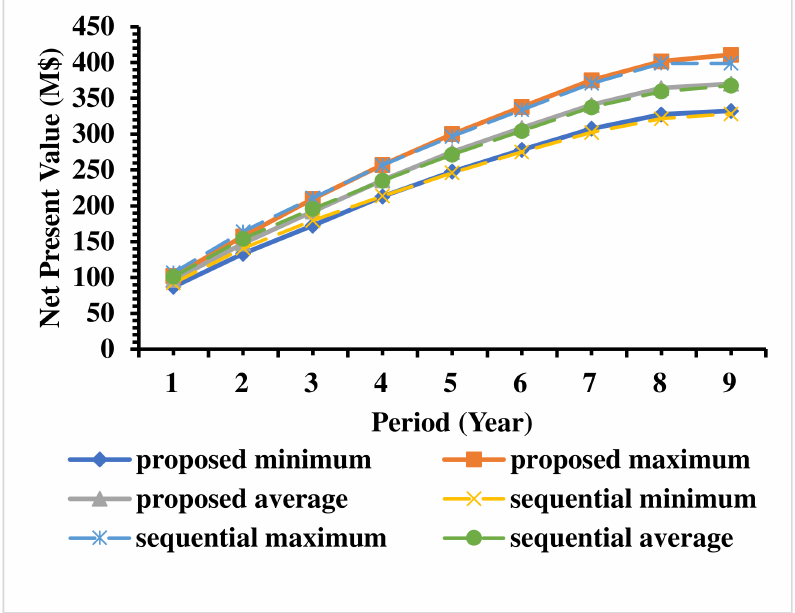
Figure 7. Cumulative discounted cash flow of the study mine using a sequential branch-and-cut